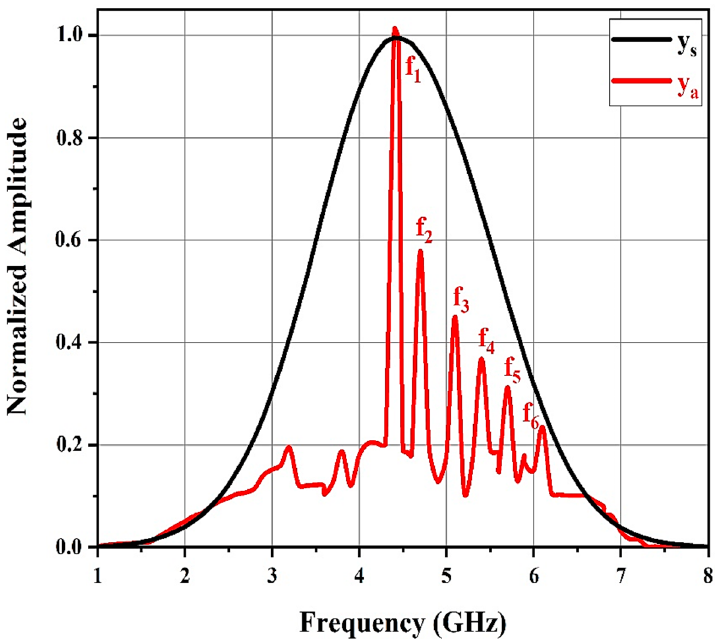
Figure 8. Normalized amplitude spectra of the structural mode ys(t) and antenna mode backscatter ya(t) obtained using fast Fourier transform (FFT).